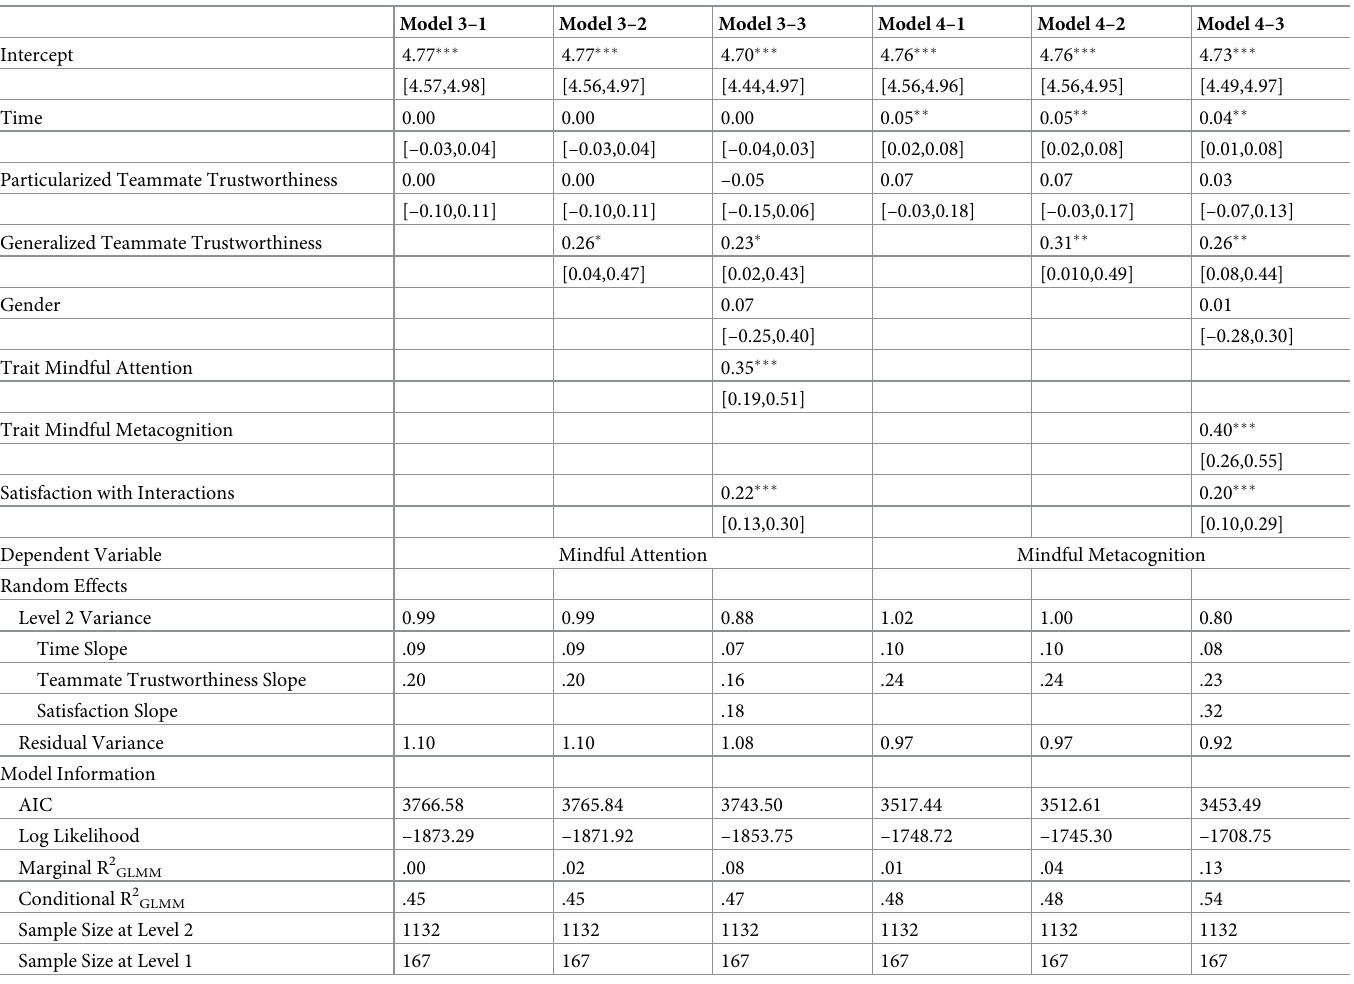
Table 3. Mixed-effects modeling for teammate